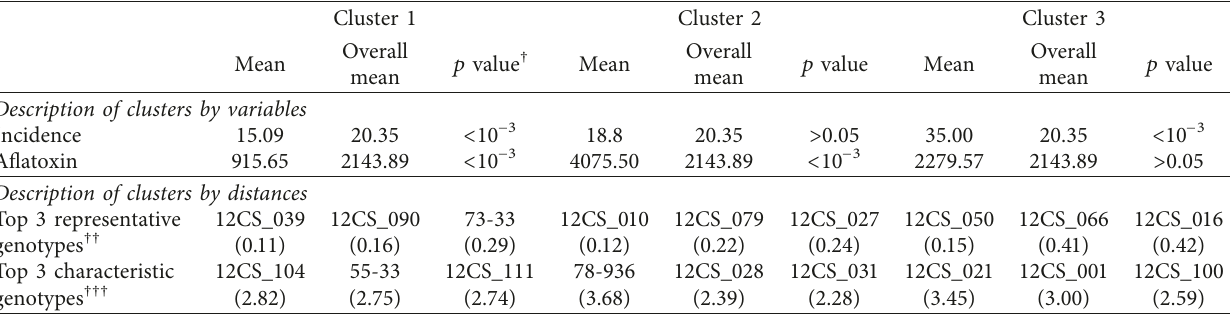
† Correlationsignification of variables with acluster. †† Based onthe closestdistance between each genotype andthe respectivecluster centres. ††† Basedon the farthest distance from a genotype projected point in a cluster to the centres of the two